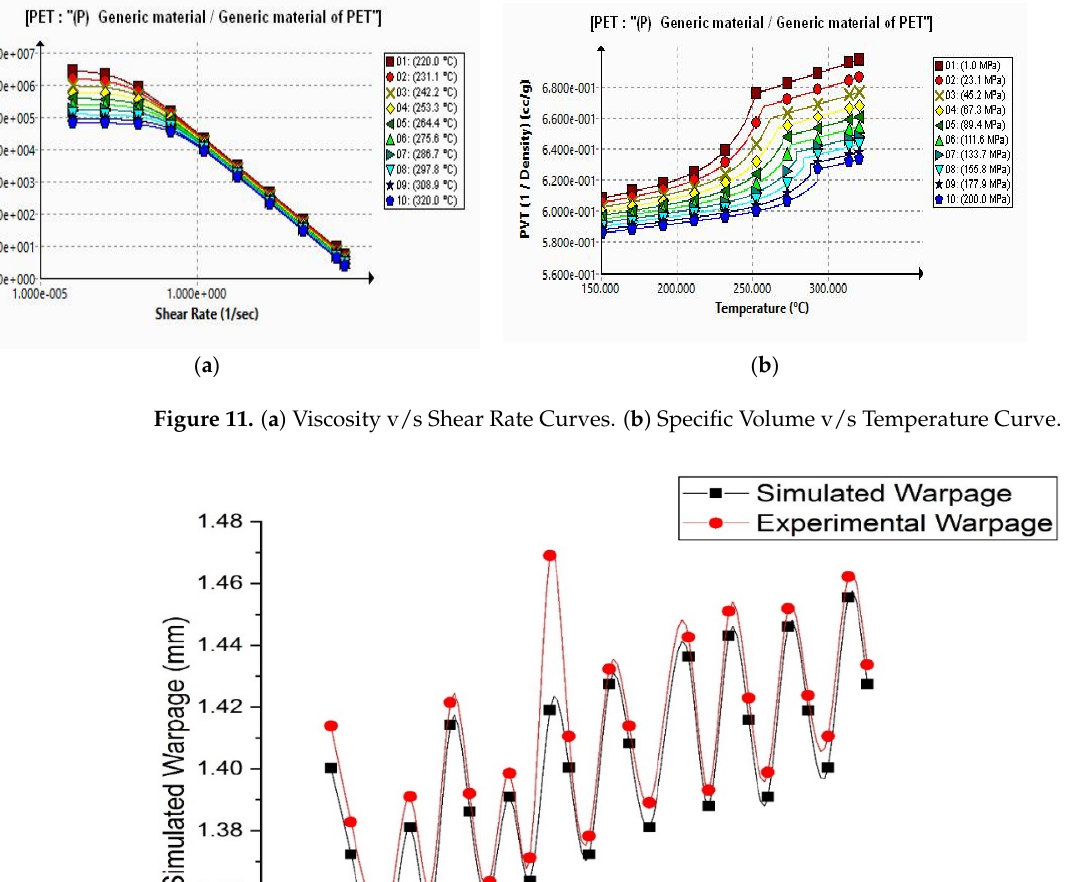
Figure 11. ( a ) Viscosity v/s Shear Rate Curves. ( b ) Specific Volume v/s Temperature Curve .